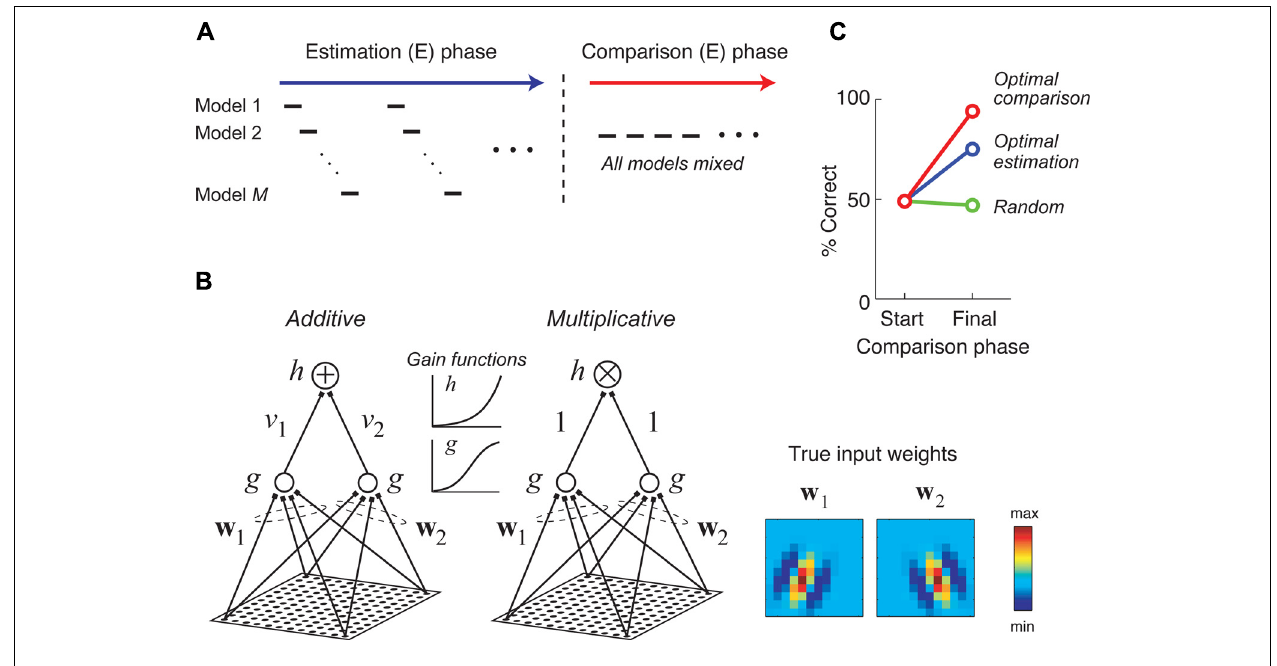
FIGURE 6 | Stimuli which are adaptively optimized for model comparison can lead to more accurate model selection. Adapted with permission from DiMattina and Zhang (2011). (A) A hypothetical two phase procedure for estimating and comparing multiple competing models. During the estimation (E) phase, stimuli are optimized in turn for estimating each model. During the comparison (C) phase, stimuli are optimized for comparing all of the models. (B) Two candidate models were fit to data generated by a true additive model whose input weights (w 1 and w 2 ) were 12 × 12 Gabor